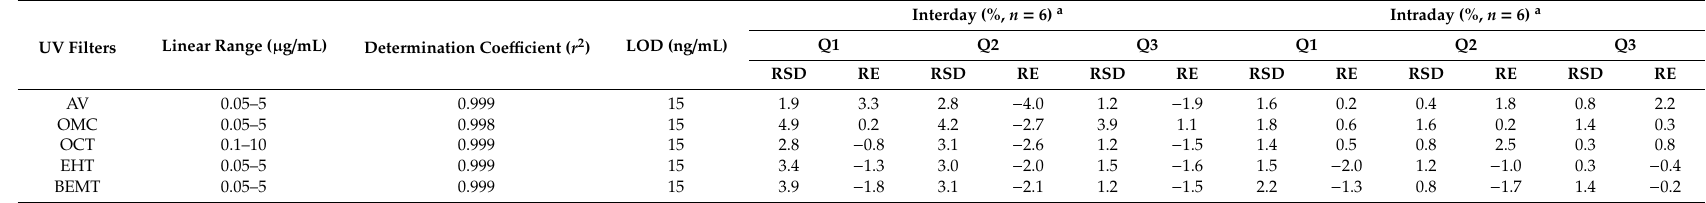
Table 2. Analytical parameters for the proposed UV filter analysis method.